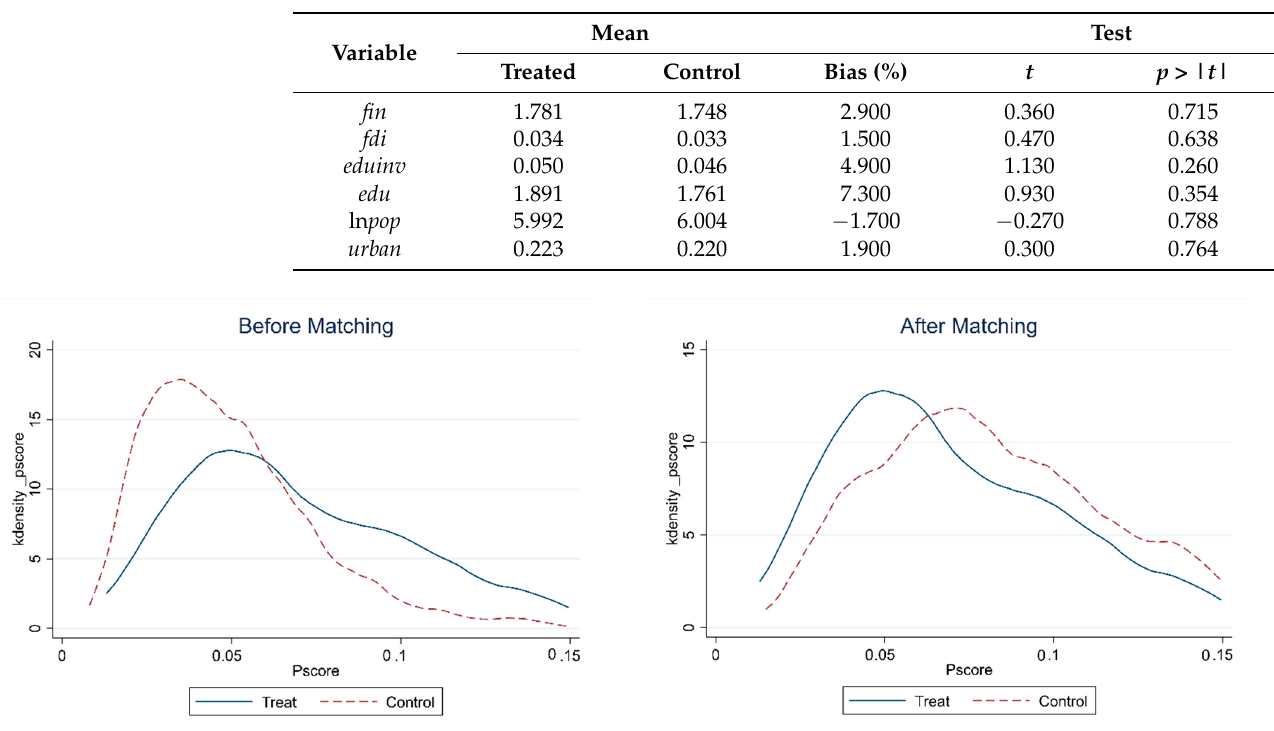
Figure 1. The probability density of the propensity scores.